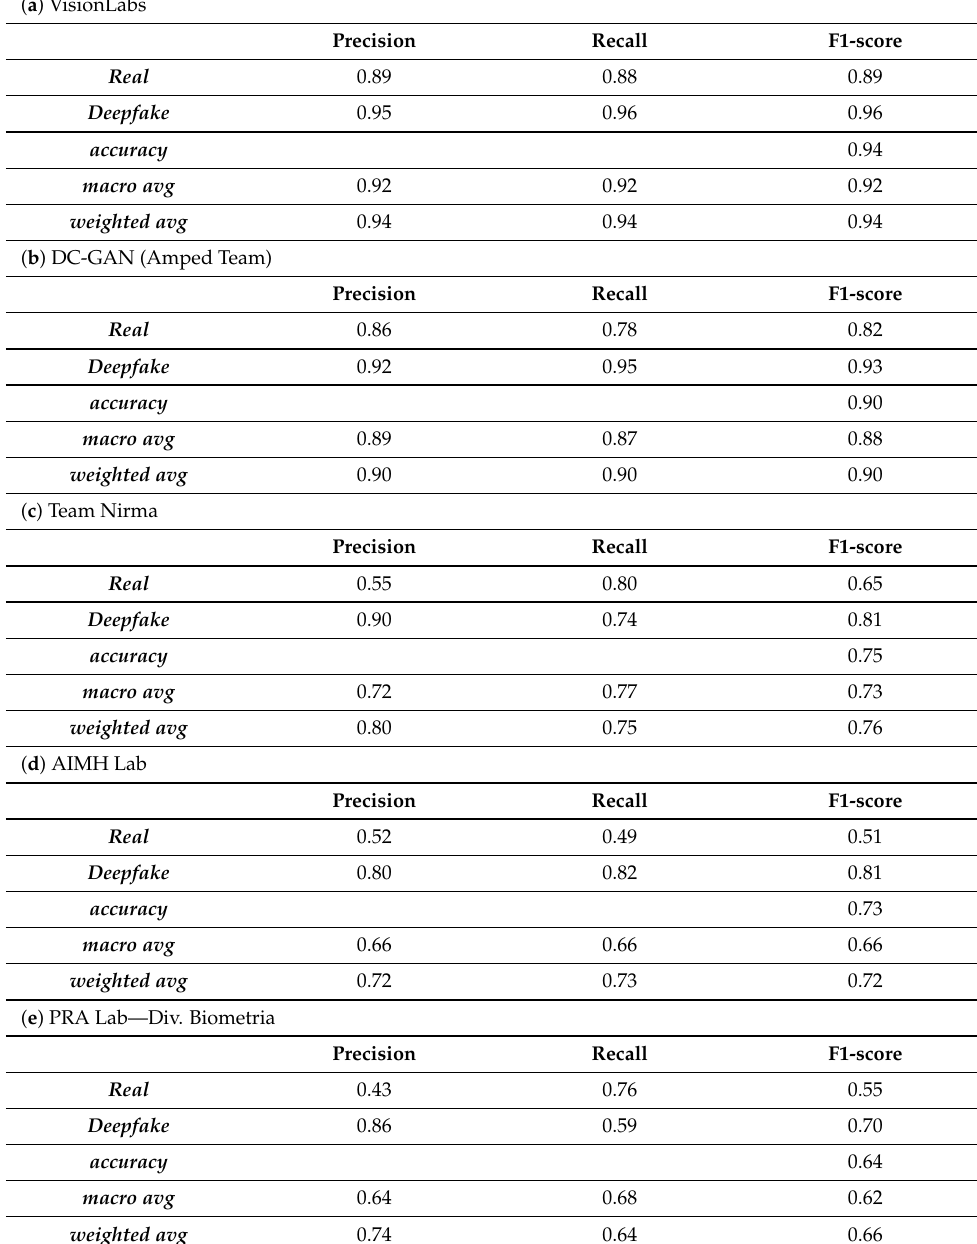
Table 3. Detailed results of Task I. Precision, recall, F1 score and their mean values are reported for each